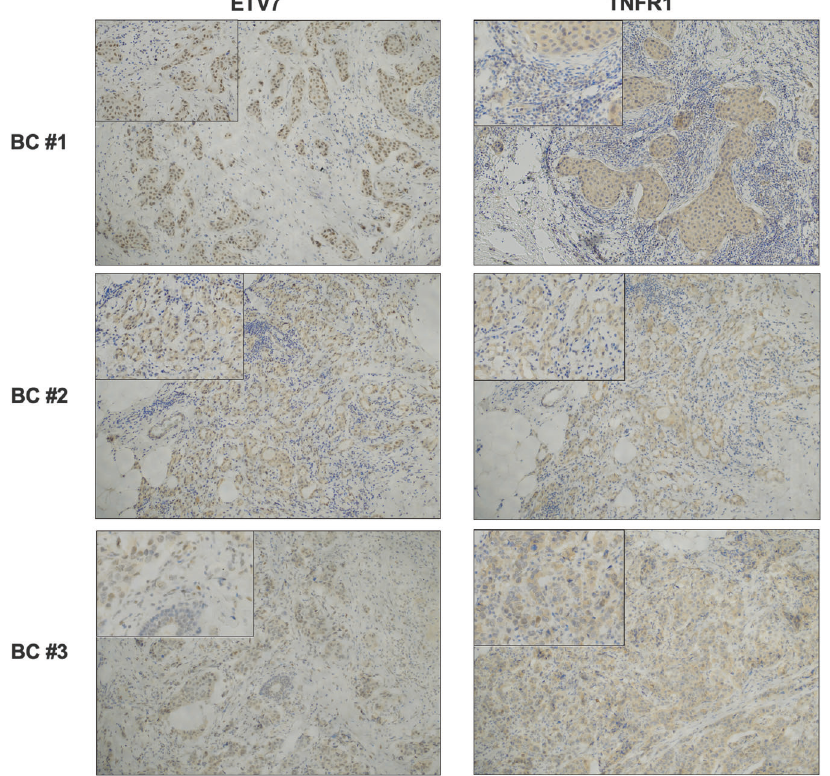
Fig. 6 An inverse correlation between ETV7 and TNFR1 in BC patients. Three samples from BC patients with invasive ductal carcinoma were analyzed by IHC. Tissues were stained with antibodies against ETV7 and TNFR1 proteins and studied at ×10 magni fi cation. A ×20 magni fi cation insert is shown for each image. Top panels: tissues from a HER2-positive BC; middle panel: tissues from a triple-negative BC; bottom panels: tissues from a luminal A